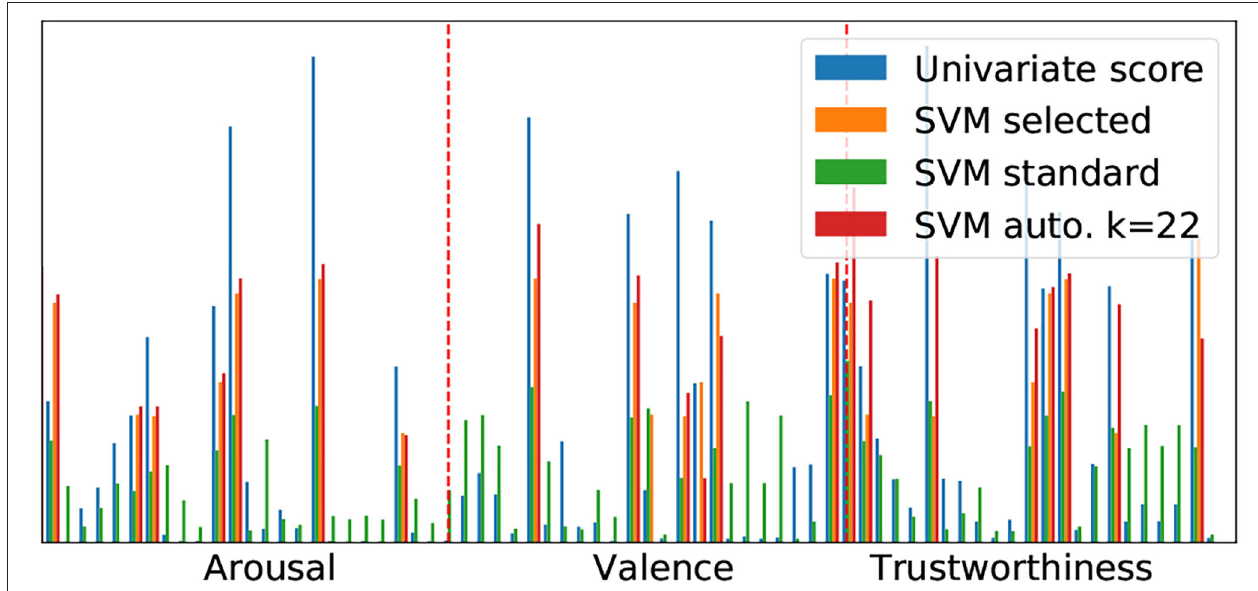
FIGURE 5 | SVM weights of arousal, valence, and trustworthiness features predicting the likes of comments comparing the use of all features, manually selected (24), and automatically selected k = 22 features. To receive a real output and fit the p -values of the automatic selection in scale, we apply a base 10 logarithm and divide the result by 10 ( − Log ( p value ) /